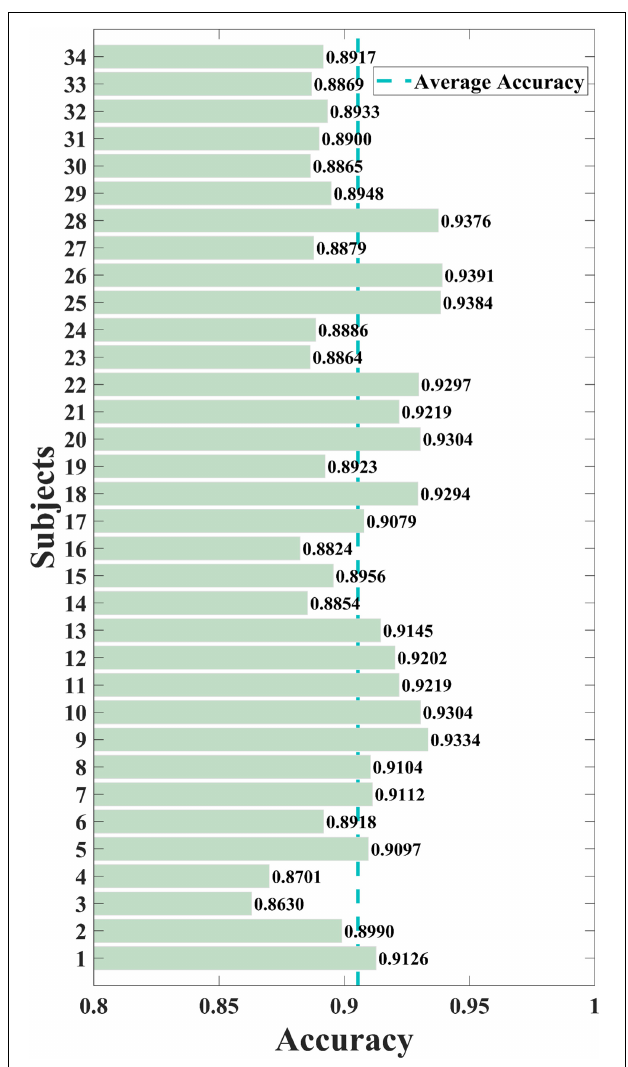
FIGURE 6 | The overall performance of the SAST-GCN model. Average Accuracy refers to average accuracy of all subjects, which is